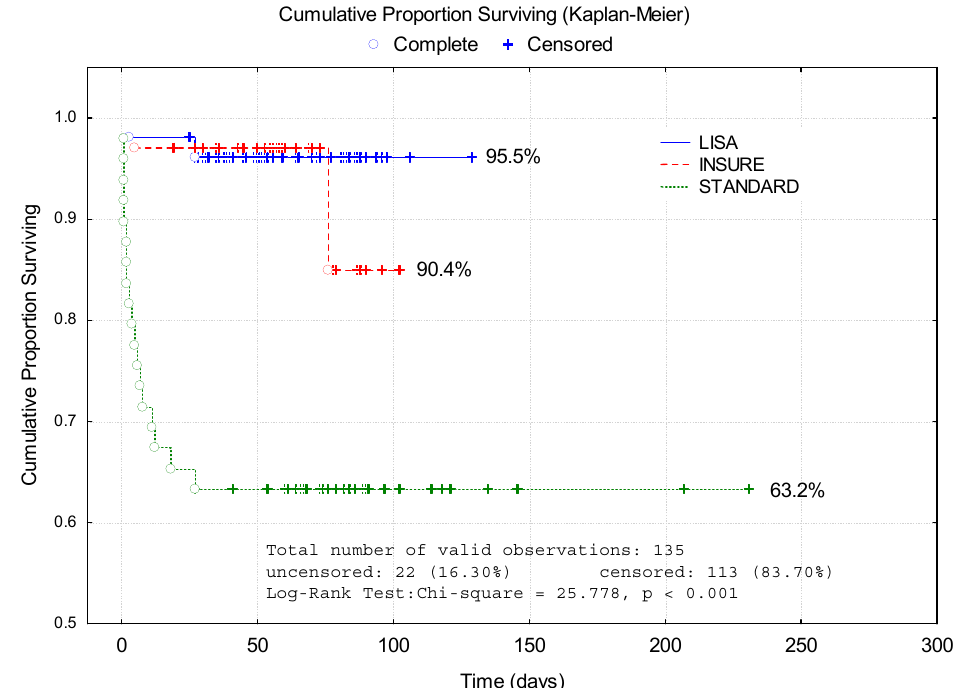
Figure 2. Comparative analysis of Kaplan–Meier curves between methods of surfactant administra- tion.